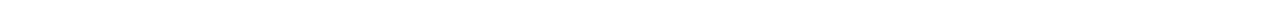
Fig. 3 Network analysis of potential CCAR1L/S-associated proteins. a Experimental setup for the interactome analysis of the two CCAR1 isoforms (including CAR1L and CCAR1S). Equal amount of vector (control)-, CCAR1L-, or CCAR1S-overexpressing A549 cells were subjected to immunoprecipitation experiments using anti-Flag antibody followed by LC-MS/MS analysis. b Gene Ontology (GO) enrichment analysis for biological process, cell component, and molecular function of up-regulated proteins. The − log10 P value of enrichment is shown on x axis; the numbers represent the number of associated proteins for each term. c Classi fi cation of candidate CCAR1L and CCAR1S interacting proteins, which are thought to be speci fi cally regulated by distinct isoforms. d IP-western validation of candidate CCAR1L (left) and CCAR1S (right) interacting proteins. CCAR1L, CCAR1S, and the indicated plasmids were transfected into A549 cells and co-immunoprecipitation assays were performed with the indicated antibodies followed by immunoblotting analysis. IP, immunoprecipitation; WCL, whole cell lysate. e KEGG analysis for differentially expressed genes (DEGs) among Sh-CCAR1L vs. Sh-Con, Sh-CCAR1S vs. Sh-Con groups. DEGs were identi fi ed following the criteria of log2ratio ≥ 1 and FDR ≤ 0.001. f Quantitative RT-PCR analysis of selected genes associated with enriched signaling pathways in CCAR1L- or CCAR1S-depleted A549 cells. Data are representative of three independent biological replicates. Unprocessed original scans of blots are shown in Supplementary Fig.